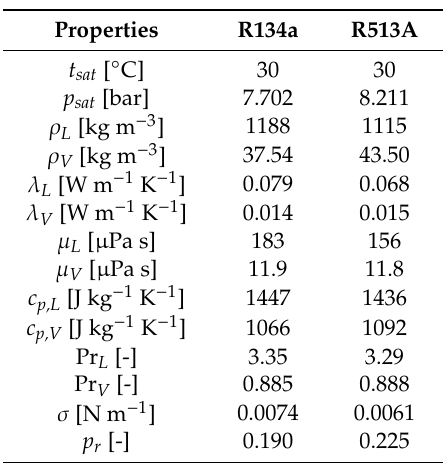
Table 1. Thermophysical and transport properties of R134a and R513A. Values from REFPROP 10 (Lemmon et al.